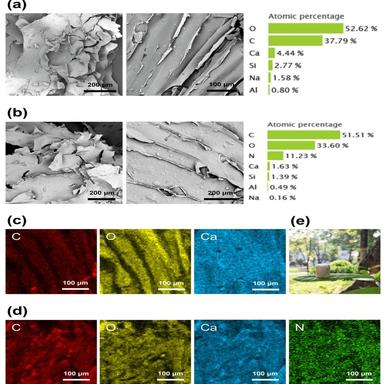
SEM images and atomic percentages of (a) SCB–Ben/SA and (b) SCB–Ben/SA/CV. EDS elemental mapping images of C, O, Ca, and N in (c) SCB–Ben/SA and (d) SCB–Ben/SA/CV. (e) Photograph of SCB–Ben/SA standing on a Dragon boat flower leaf.